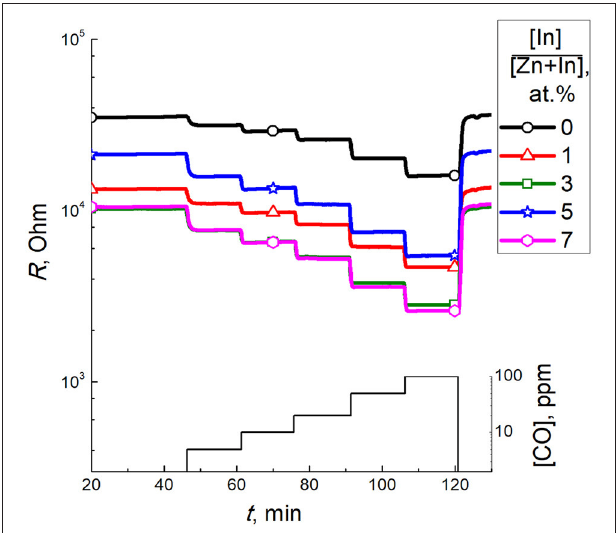
FIGURE 8 | Dynamic response of zinc oxide modified by different amounts of In 2 O 3 to 5–100 ppm CO at 450 ◦ C.